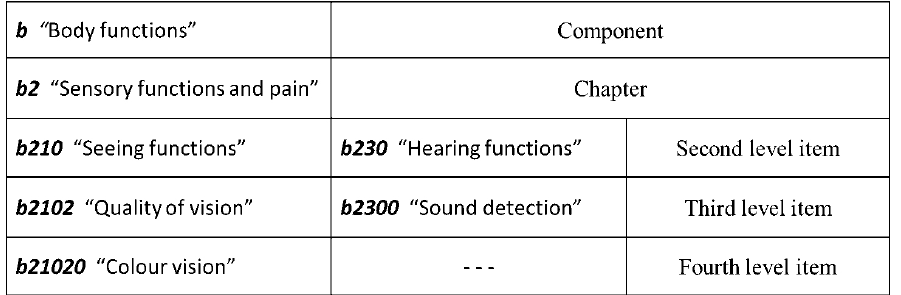
Figure 2. An example of ICF (International Classification of Functioning, Disability and Health) illustrating the structure of the classification.